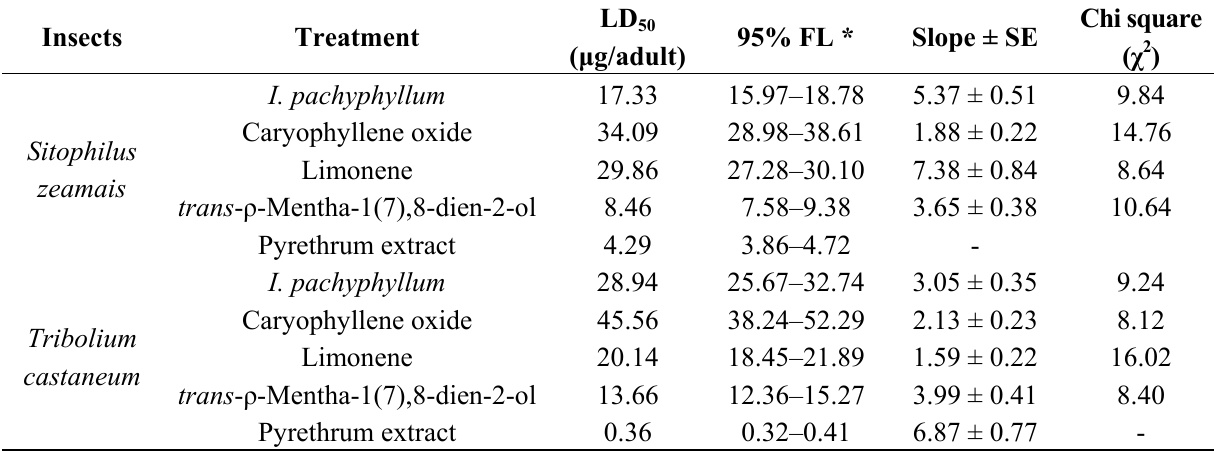
Table 2. Contact toxicity of the essential oil of Illicium pachyphyllum fruits and its constituents against Sitophilus zeamais and Tribolium castaneum